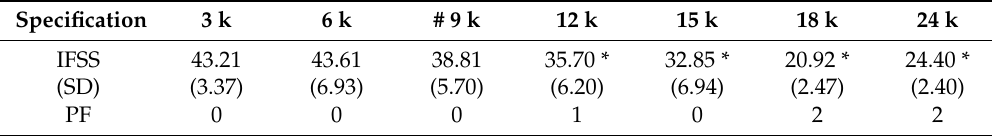
Table 2. IFSS results of seven varied tow bundle sizes tested under Iosipescu testing.